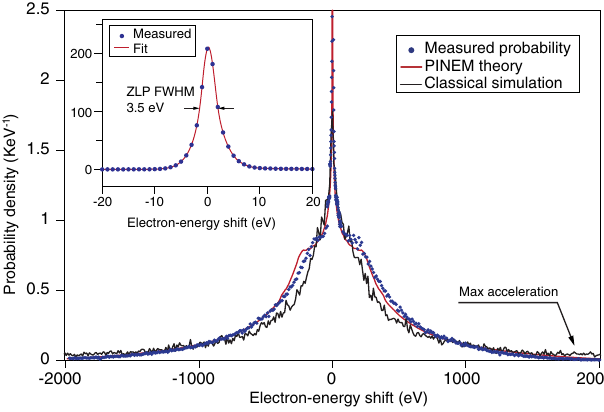
FIG. 3. Measurement of DLA in the UTEM and comparison with theory. The EELS measurement shows the electron accel- eration and deceleration. The recorded initial energy spread of the electron pulse is 3.5 eVat FWHM (left inset), while the measured postinteraction energy spectrum has a bandwidth of 4000 eV (blue dots). The maximum achieved acceleration is 2000 eV determined by the point at which the signal approximately reaches the noise level of the spectrometer. For this measurement, we set our spectrometer dispersion at 1 eV per channel (total channel number: 2000), record each side of the spectrum (gain and loss) separately with a small overlap, and then splice them together. This coarse dispersion allows us to capture the full spectrum with two shots only, but on the other hand, it measures a broader ZLP than it actually is. As a result, the EELS dispersion conceals the quantum features (see Fig. 4). We show that both the particle-tracking simulation, which is based on the classical DLA theory (solid black line), and the PINEM theory (solid red line) produce good predictions of the measured spectrum. The hori- zontal error for each point on the measured curves is determined by the measured initial energy width of the electron beam (1.49 eV) and by the detector resolution ( (cid:4) 1